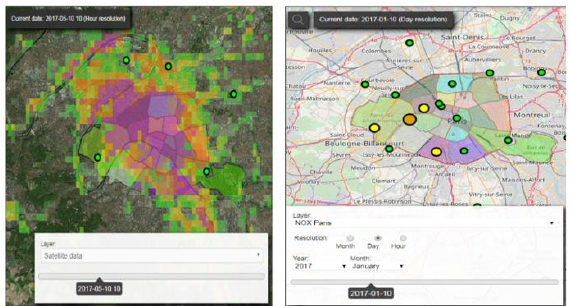
Figure 10. Time-series data examples: Air quality Satellite (raster, left) and Air Quality from Monitoring stations (vector,